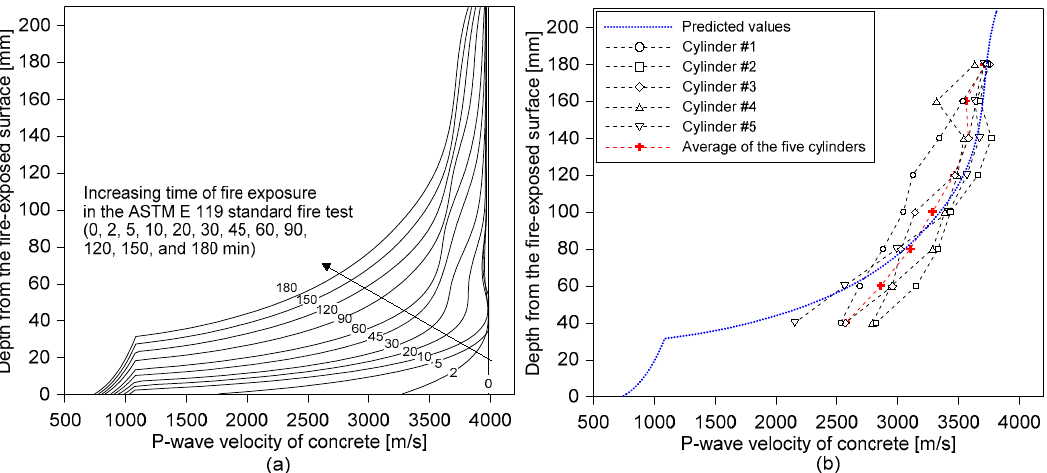
Figure 15. P-wave velocity of concrete with depth: ( a ) predicted P-wave velocity profile of fire-damaged concrete with increasing time of fire exposure after the ASTM E 119 standard fire test, and ( b ) comparison of the P-wave velocity profiles of concrete, estimated by the discrete layered model and measured by ultrasonic pulse wave velocity measurement of the cored cylinders from the fire-damaged concrete specimen after the 3-hour exposure to standard fire testing.